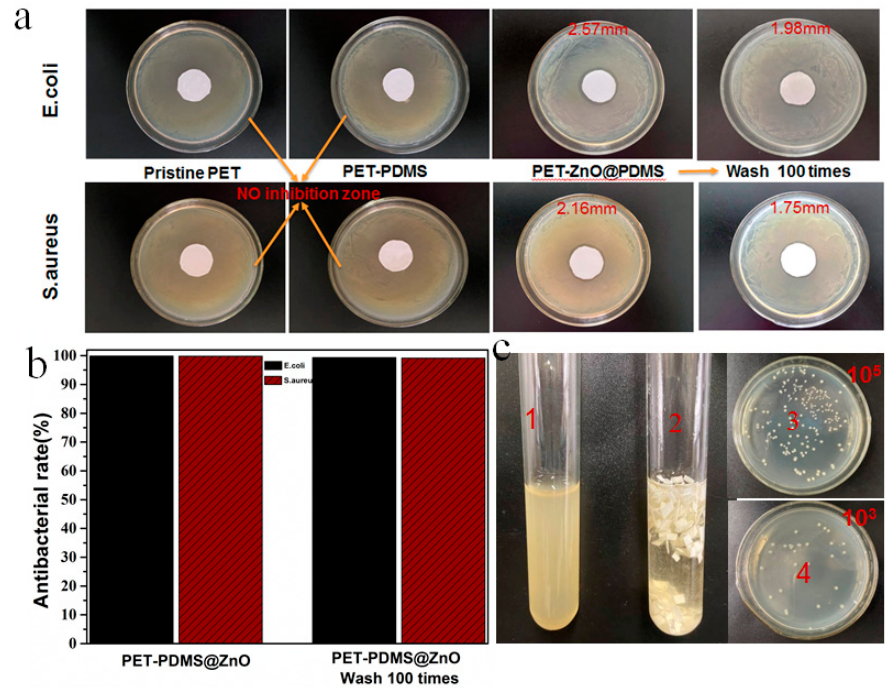
Figure 5. Antimicrobial tests. ( a ) Optical images of inhibition zone of different fabrics; ( b ) Bacterio- static rate of PDMS@ZnO coated fabric before and after washing 100 times, with E. coli and S. aureus bacteria; ( c ) Blank group (No.1 and 3) and experimental group (sample of PET-PDMS@ZnO, No. 2 and 4) of Antimicrobial tests.